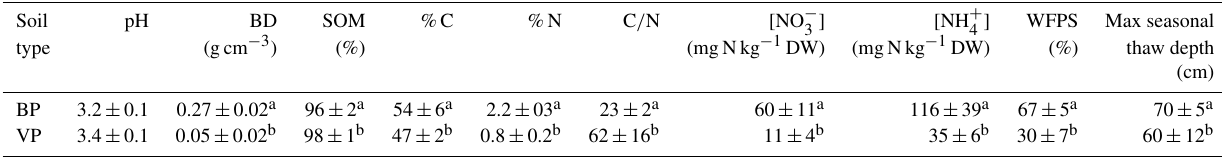
] [NH + ] WFPS Max seasonal 3 4 (cm)